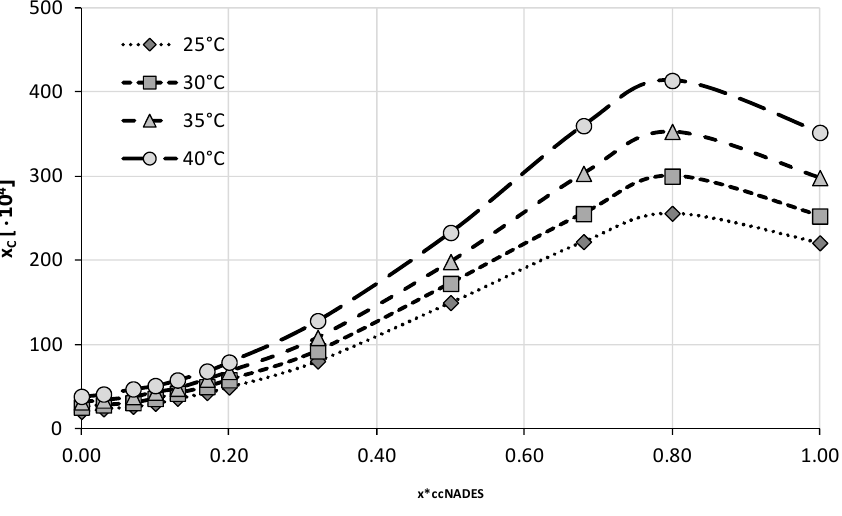
Figure 5. Mole fraction solubility of caffeine in mixtures of water and NADES comprising choline chloride and sorbitol in 1:1 molar ratio. On the abscissa, x* ccNADES represents the mole fractions of the ccNADES in solute free binary solutions.